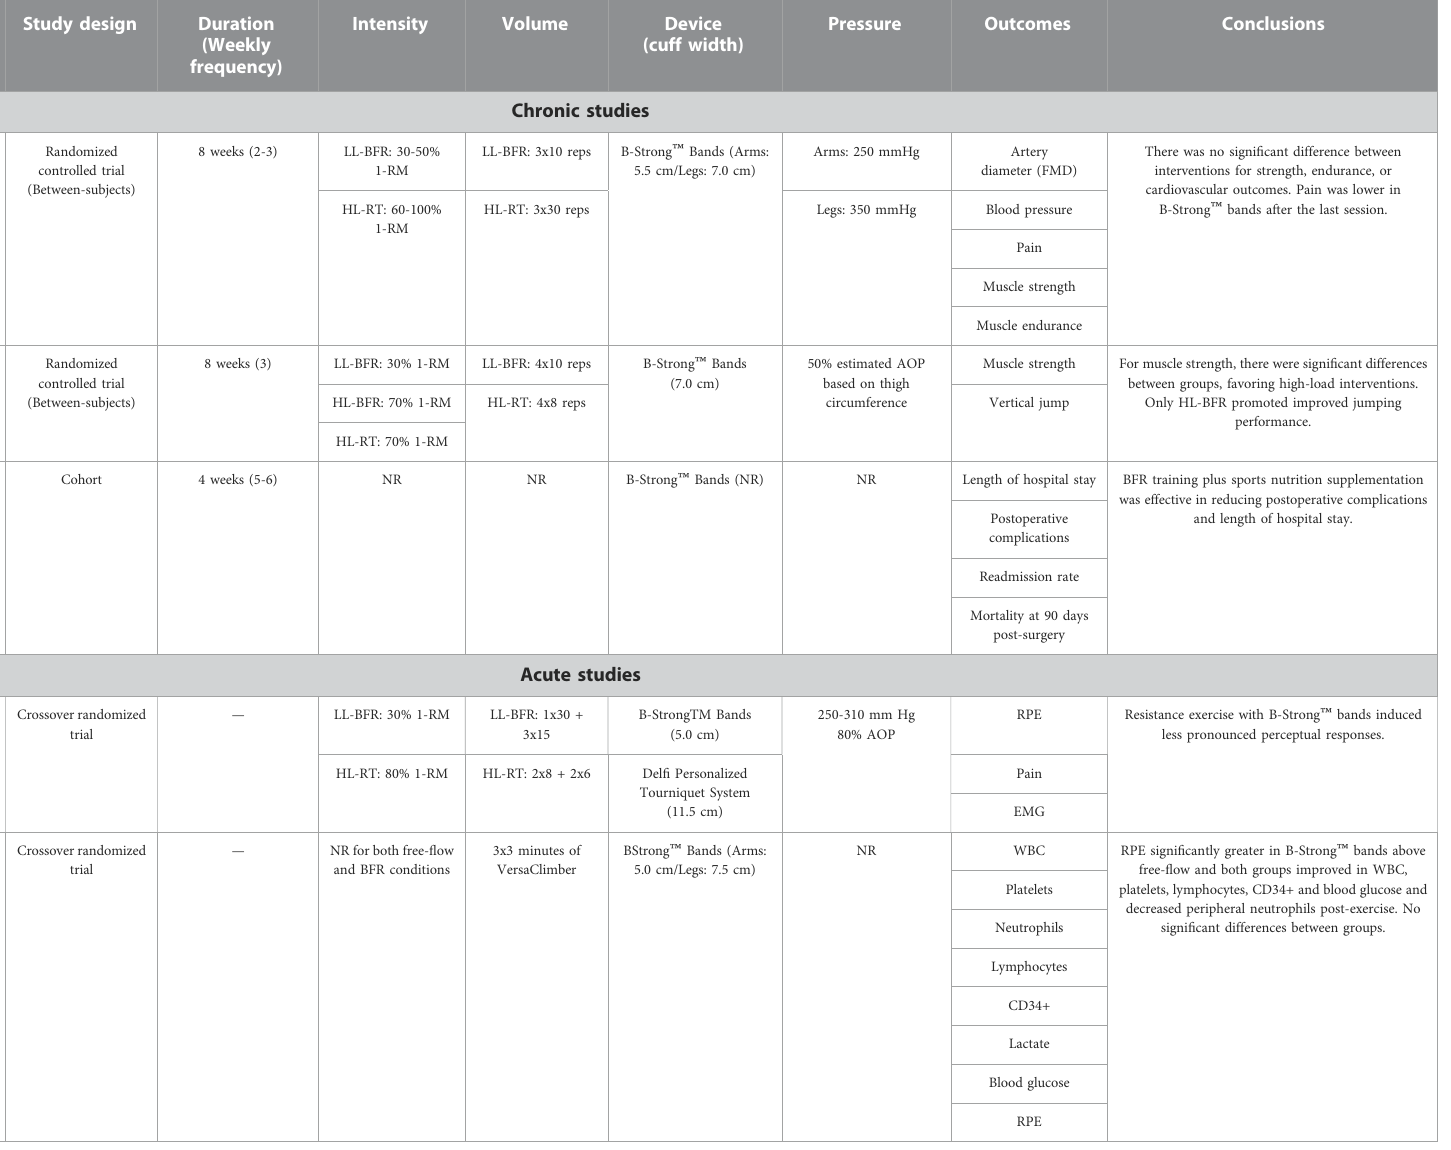
TABLE 1 Summary of available acute and chronic blood fl ow restriction training studies using a multi-chambered bladder